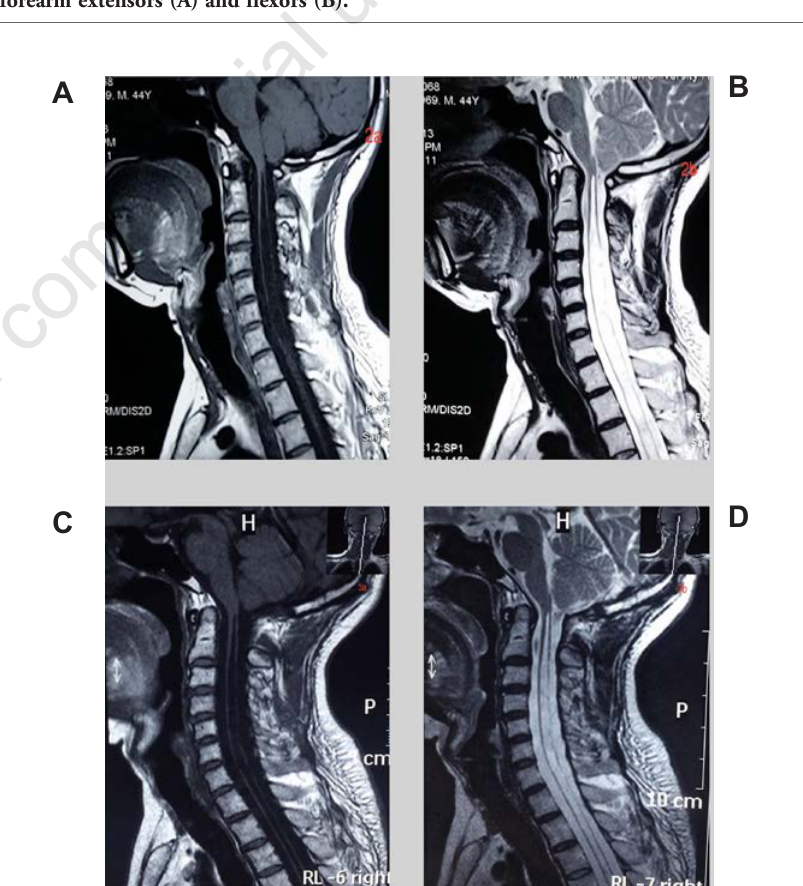
Figure 2. Preoperative magnetic resonance imaging scans demonstrating the syrinx from the level of C1 extending inferiorly into the thoracic spinal cord (A and B), and at 2 years’ follow-up showing the shrinking syrinx (C and